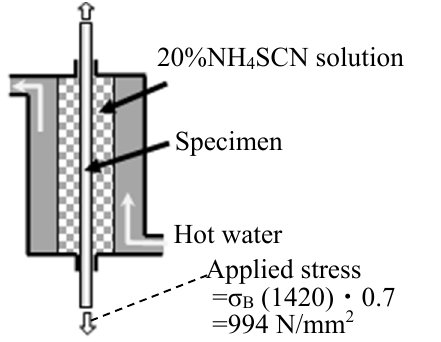
Figure 3. Schematic diagram of FIP test method.